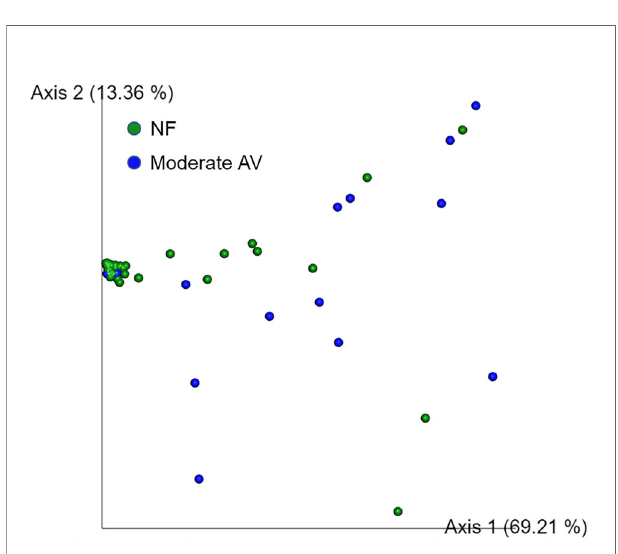
FIGURE 3 | Principal coordinate analysis (PCoA) of the three groups based on weighted UniFrac distances. Each group was classi fi ed based on the aerobic vaginitis scoring system. NF and moderate AV represent normal fl ora (green) and moderate aerobic vaginitis (blue), respectively. Each axis (axis 1 and 2) represents a Principal Component (PC), and the sum of the two axes explanatory power is